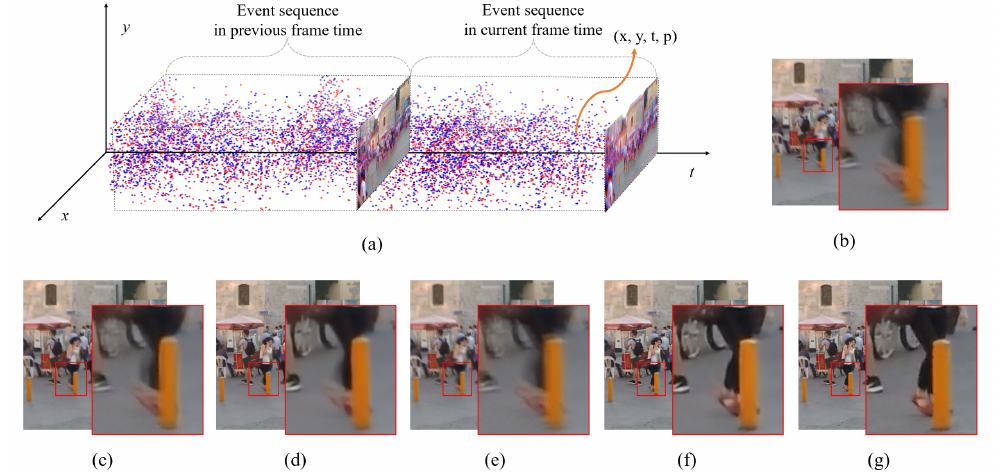
Figure 1. ( a ) Event sequence data. ( b ) Current blurry frame. ( c ) STFAN [5] result. ( d ) CDVD-TSP [8] result. ( e ) ESTRNN [10] result. ( f ) Proposed MEVDNet result. ( g ) Ground